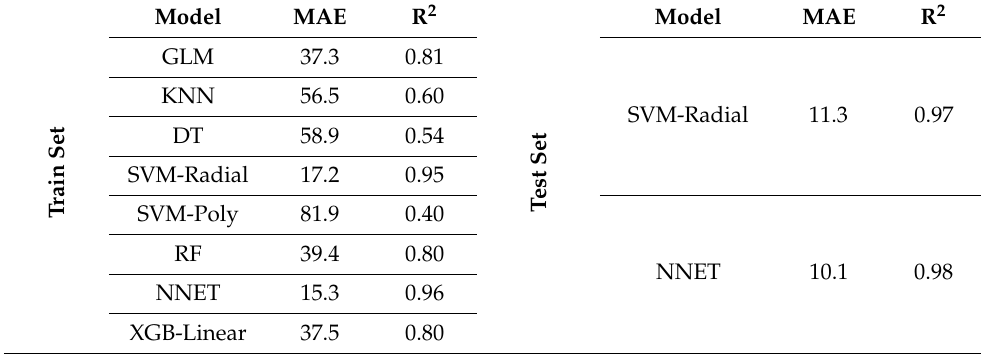
Table 4. Layer-2 Models Performance (4-Bus System).